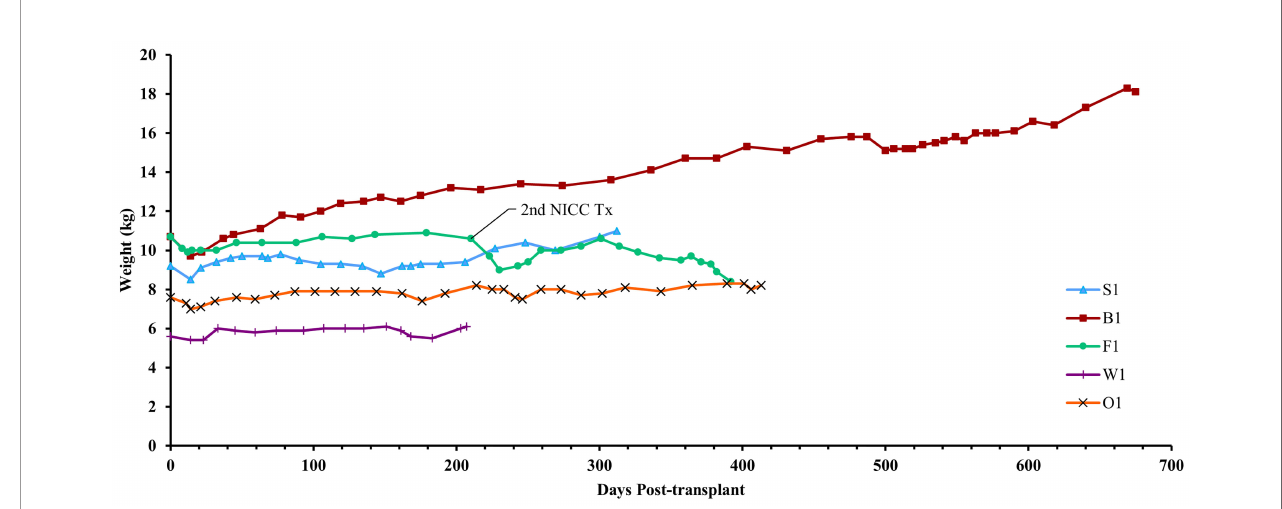
FIGURE 5 | Recipient weights. After a small weight loss following surgery, all recipients gained weight over the course of the experiment. Recipient F1 initially gained weight but then lost weight after developing